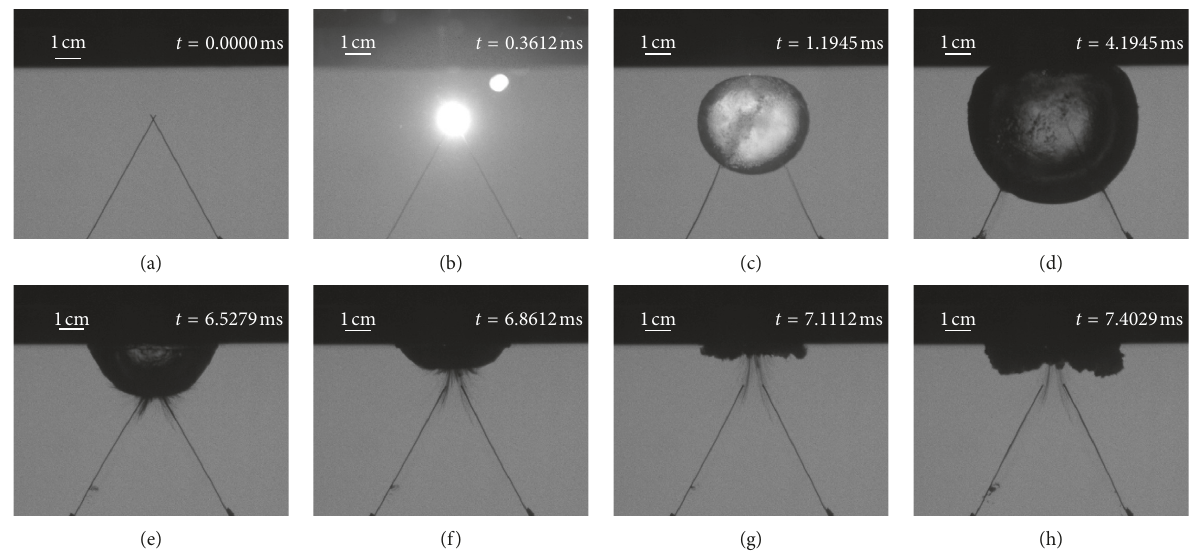
Figure 6: Evolution of the first cycle of the underwater spark-generated bubble’s expansion and collapse below the target plate with 20mm standoff. (a) t 0.0000ms. (b) t (cid:30) (h) t 7.4029ms. (cid:30)